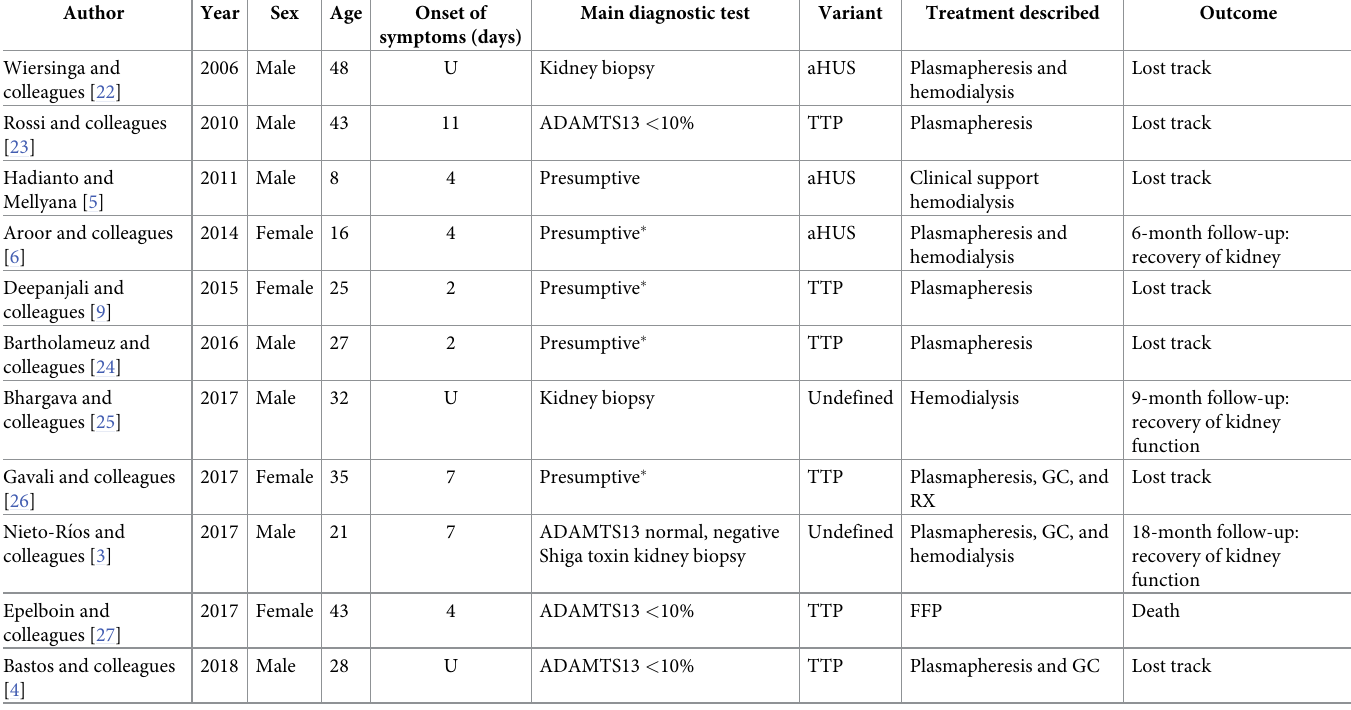
Table 1. Demographic characteristics, treatment, and renal outcome in 11 patients with TMA related to dengue